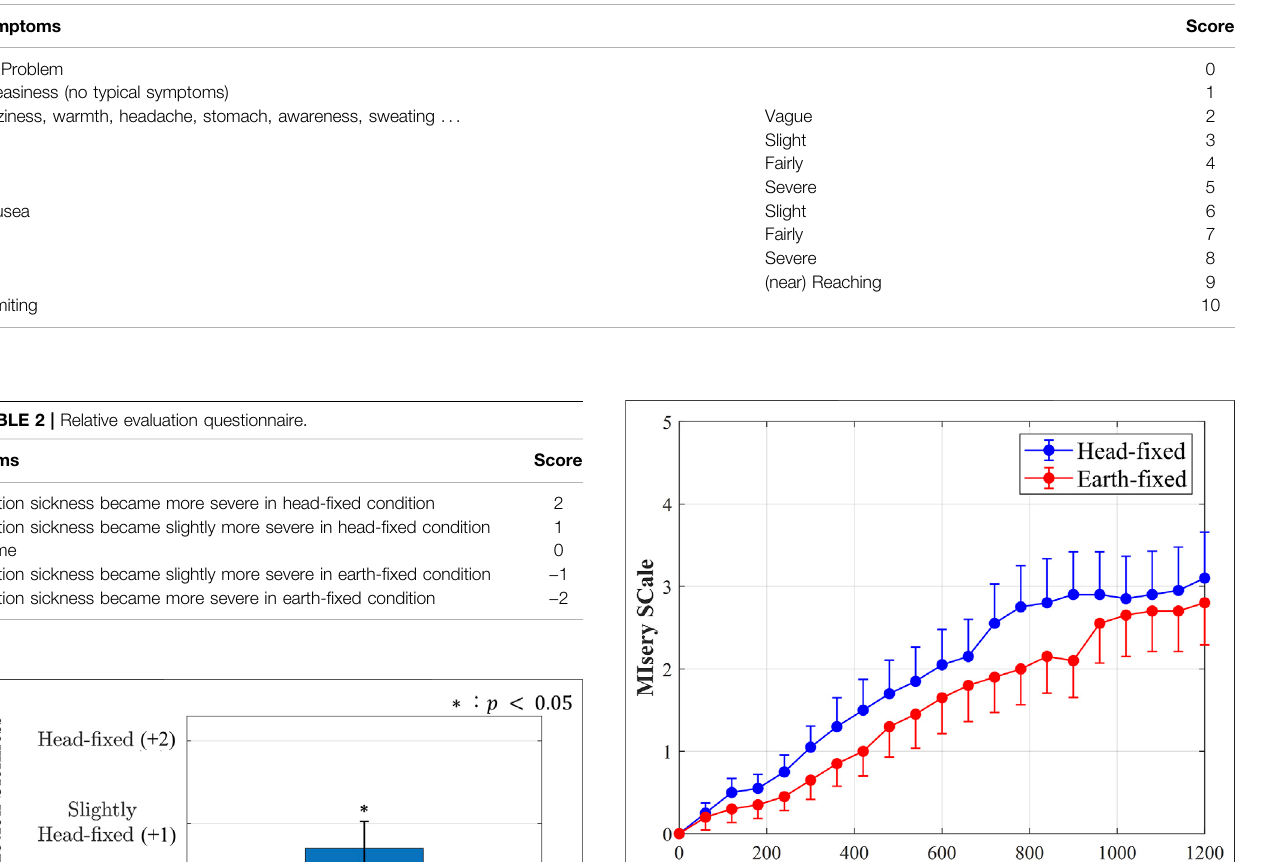
TABLE 1 | MIsery SCale.